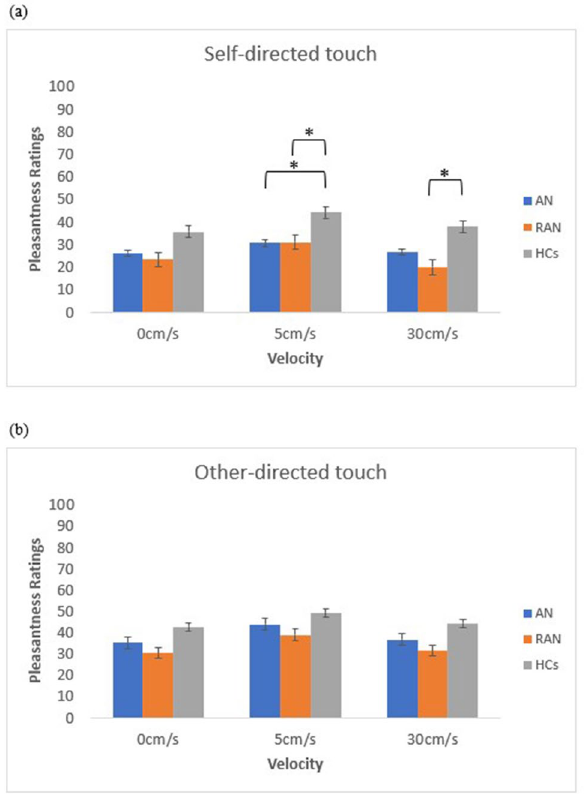
Figure 2. Pleasantness ratings for each velocity, which have been collapsed across body sites, with each bar representing one of three groups (AN, RAN and HCs). Graphs are separated for each task: ( a ) self-directed touch and ( b ) other-directed touch.